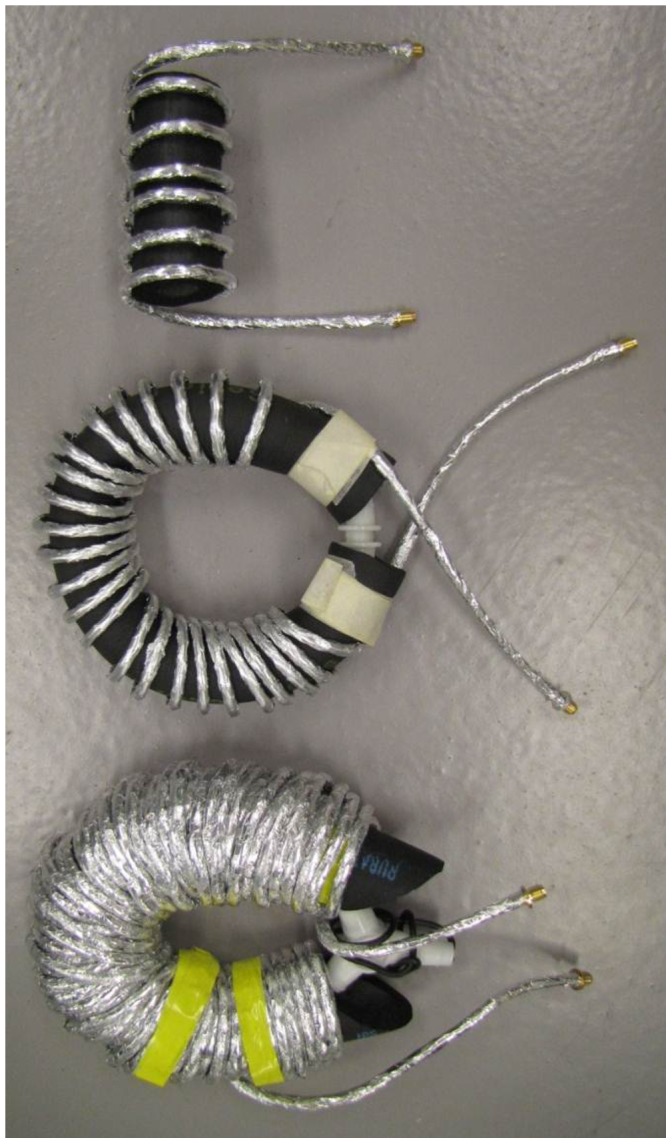
Long helical cells with continuously varying B1 versus B angle.The sample-compartment lengths are 75, 300, and 1215 cm, respectively. The coax is wound around a supporting piece of elastomer into a helix or a toroidal helix.